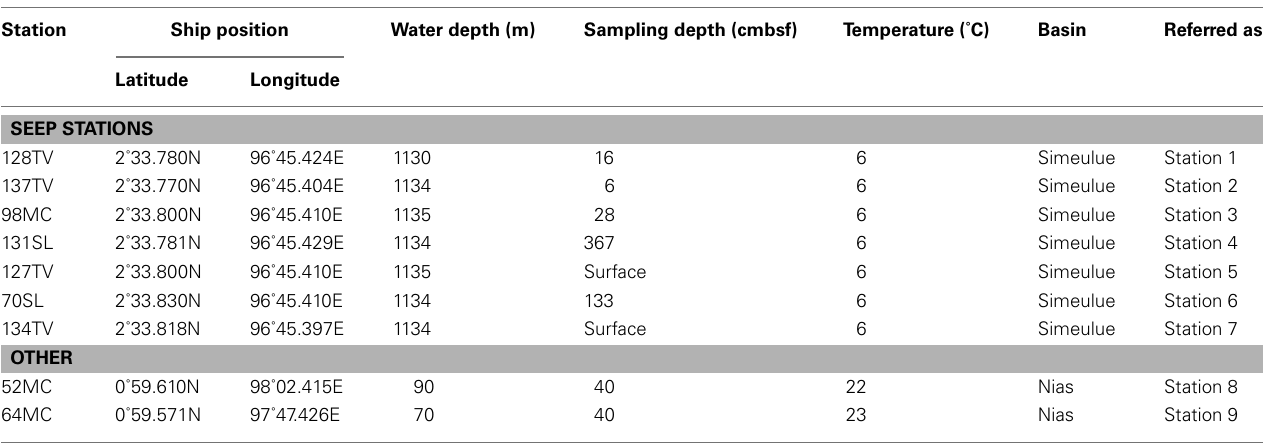
Table 1 | Sampled stations in forearc sediment basins off